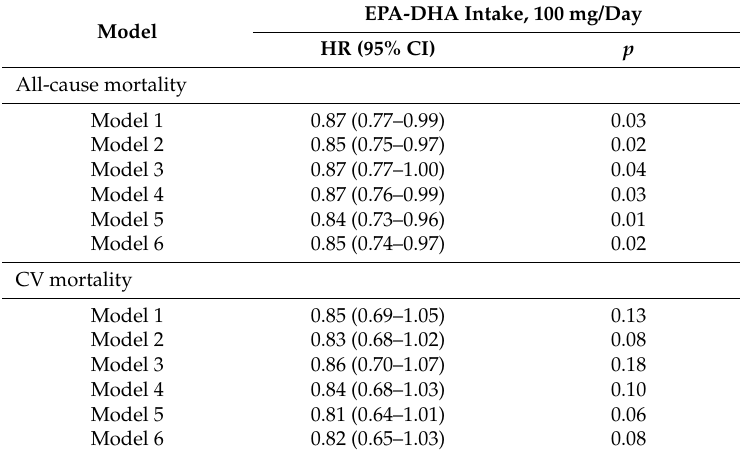
Table 2. Prospective analysis of EPA-DHA intake (100 mg/day) on all-cause and CV mortality in RTR.